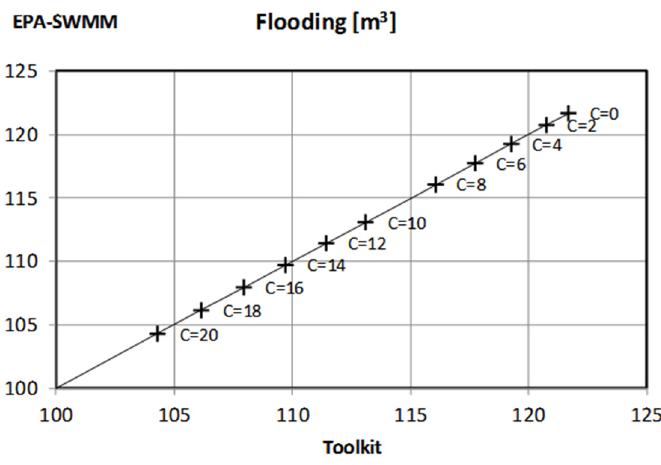
Figure 6. Flooding results comparison between EPA SWMM and a Toolkit-based application.